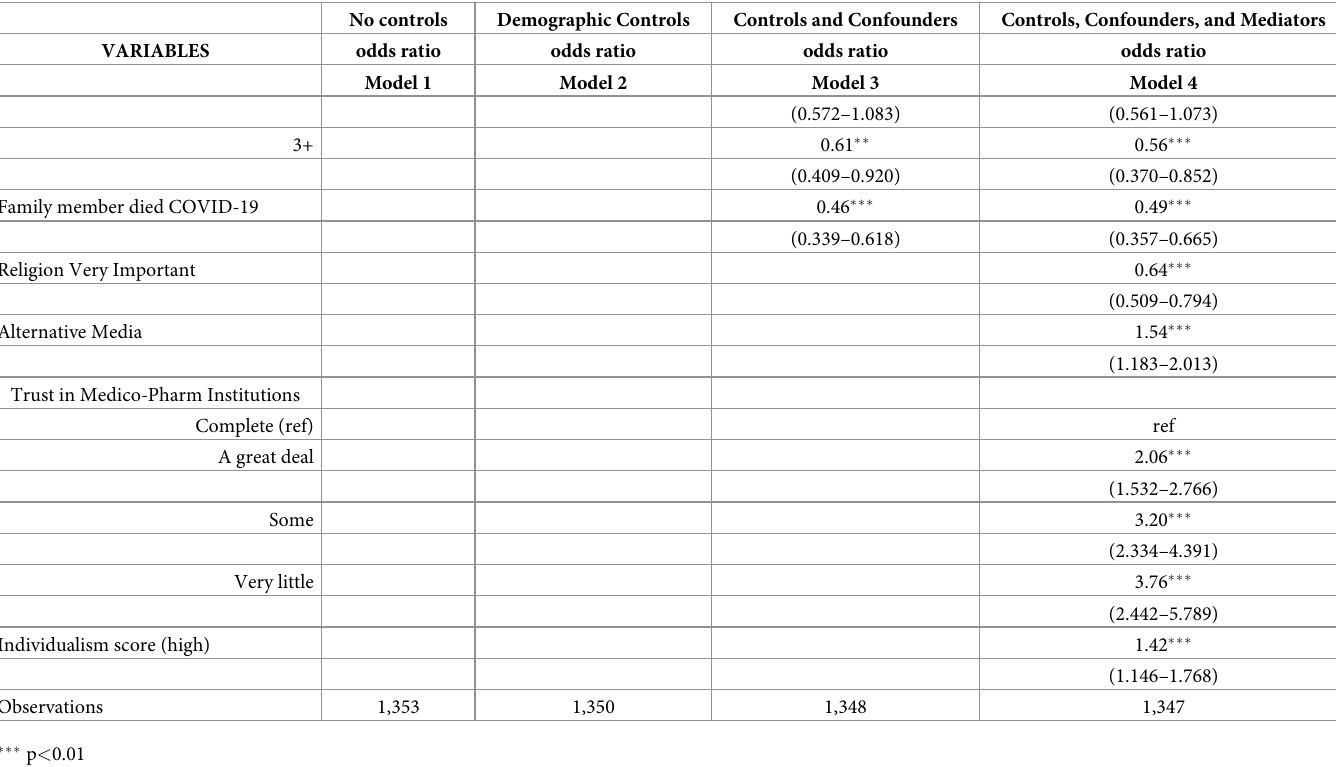
(Table 2, Model 4, OR = 3.76, p < 0.01). Scoring high on the individualism scale was also associ- ated with a lower intent to vaccinate (Table 2, Model 4: OR = 1.42, p <